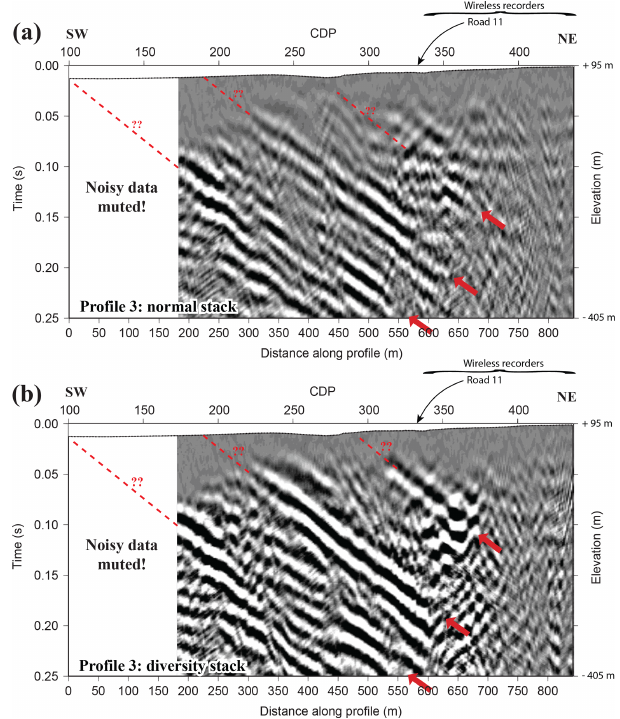
Figure 7. Comparison between (a) normal amplitude stack and (b) diversity-based stack on the data along profile 3 illustrating much better quality imaging of the reflections obtained using di- versity stack. Note that the northeastern-most reflection marked by a red arrow is very notable in panel (b) . Dashed lines provide a pos- sible projection of the reflections towards the surface. Data on the southernmost portion of the profile were noisy and hence excluded from the